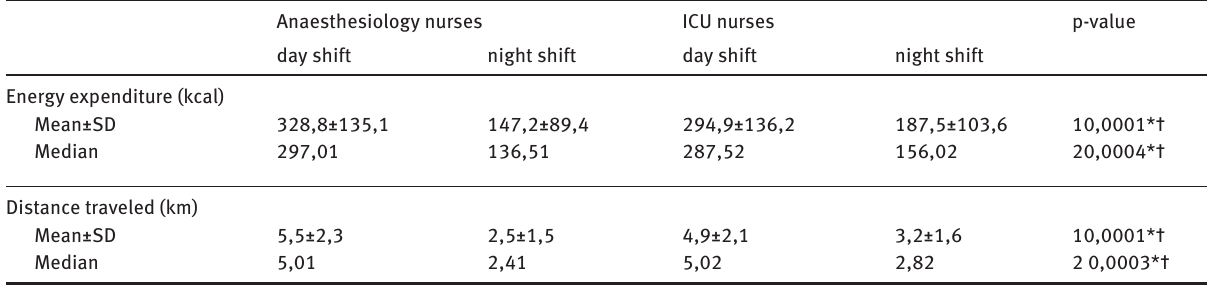
Table 5: Comparison of day vs night shift (energy expenditure, number of steps, distance